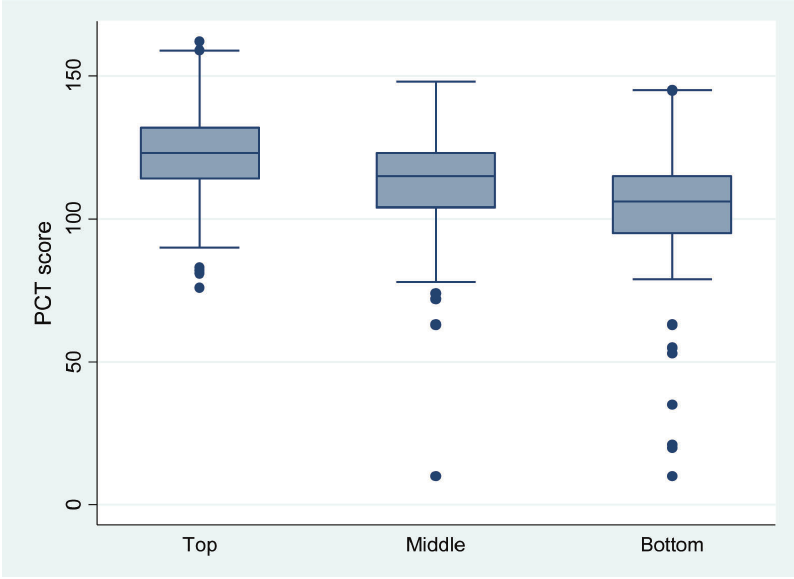
Figure 3: Distribution of PCT scores: sample pupils across streams n = 835; Mean for all pupils = 114.6. Line represents median, box represents 25th and 75th percentiles (Q1 and Q3, respectively), whiskers represent Q3+1.5(Q3–Q1) / Q1–1.5*(Q3–Q1).